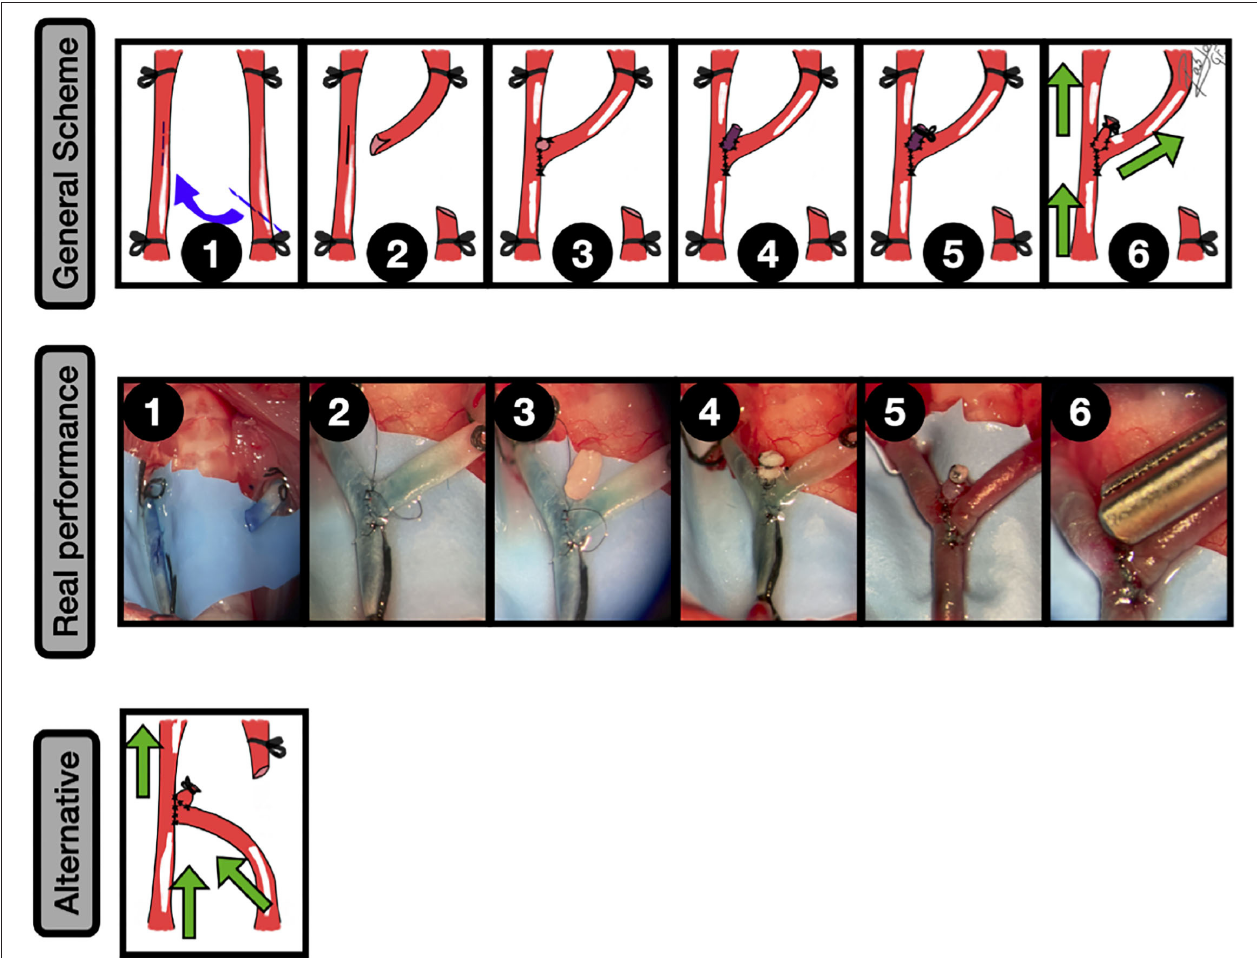
FIGURE 9 | Neobifurcation aneurysms. General scheme: 1: Bilateral CCAs exposure and proximal and distal ligation. A longitudinal arteriotomy in the anterolateral wall of the left CCA is done and an oblique arteriotomy facing the contralateral artery in the second CCA is performed; 2: The picture shows the anastomosis construction and the fish-mouth arteriotomy in the recipient artery; 3: An end-to-side anastomosis between both CCAs leaving a hole on the top is performed; 4: A free venous graft from a jugular vein is placed on the top of the construction and anchored by a couple of knots; 5: The anastomosis between the graft and the hole is completed and the free lumen of the graft occluded; 6: The clamps are released, leading to an aneurysm formation in the bifurcation. The green arrows indicate the blood flow direction. Real performance: 1: Exposure of both CCAs and subsequent arteriotomies in an end-to-side fashion, including a fish-mouth arteriotomy of the recipient artery (right). The vessels are dyed by methylene blue; 2: The end-to-side anastomosis between both CCAs is performed, leaving a hole in the top that will be the neck of the aneurysm; 3: A free venous graft from a jugular vein is harvested and transferred to the anastomotic area in the showed place; 4: A second end-to-side anastomosis between the free graft and the hole is performed, and a 6/0 silk ligature is utilized to occlude the free lumen of the venous graft; 5: The clamps are released, leading to an aneurysm formation in the bifurcation; 6: The aneurysm is further clipped. Alternative: Confluence aneurysm by an end-to-side anastomosis between the CCAs + venous graft to recreate the aneurysm. The blood flow has a different direction from the aforementioned example. The green arrows indicate the blood flow